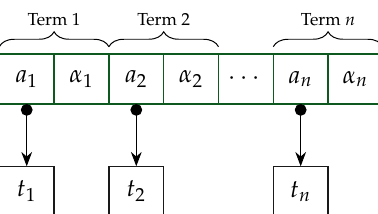
Figure 1. An alternating array representation of n terms showing GMP trees as t 1 , t 2 , ..., t n , GMP heads as a 1 , a 2 , ..., a n , and monomials as α 1 , α 2 , ..., α n . One head and tree together make a single arbitrary-precision